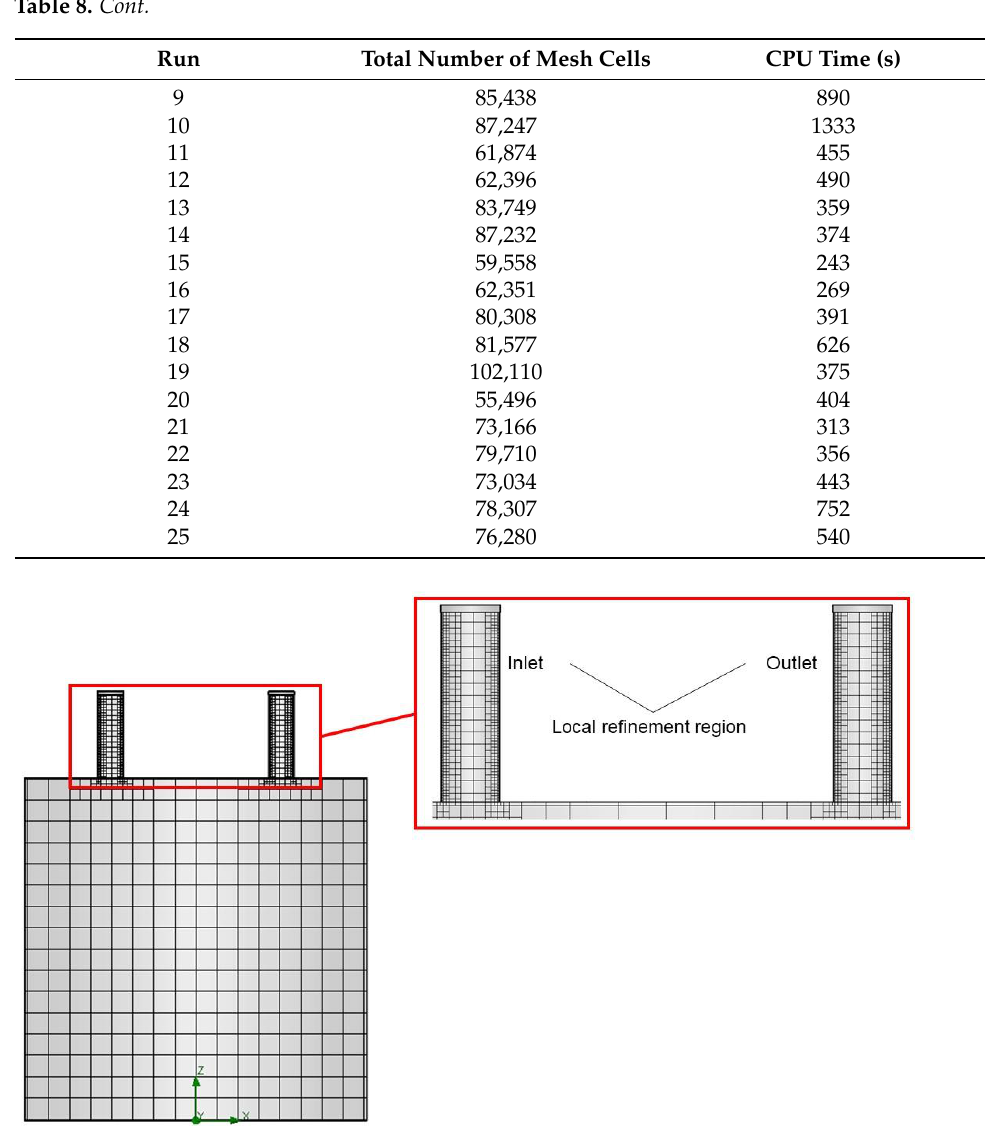
Figure 12. Representation of mesh created after definition of global and local meshes for the geometry with upper air inlet and outlet.